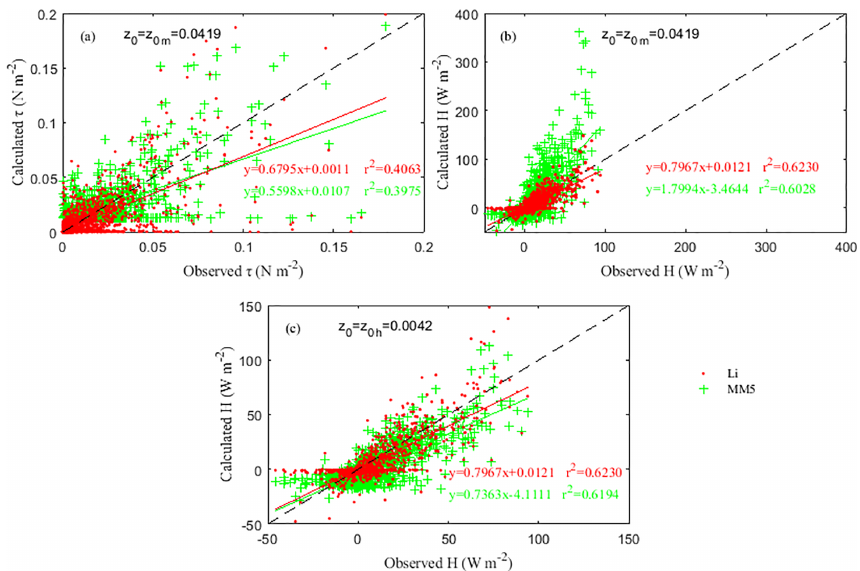
Figure 6. Comparison of calculated and observed fluxes at Gucheng station from 1 December 2016 to 9 January 2017. (a) Momentum fluxes (MM5: z 0 = 0 . 0419); (b) sensible heat fluxes (MM5: z 0 = 0 . 0419); (c) sensible heat fluxes (MM5: z 0 = 0 . 0042). Red dots: the Li scheme; green plus signs: the MM5 scheme.